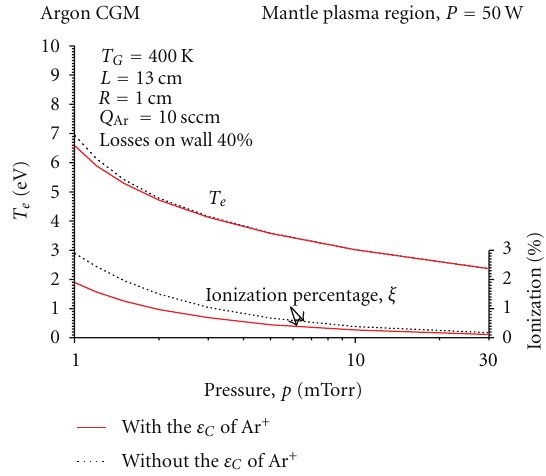
Figure 15: Calculated T e and ionization percentage in the mantle plasma region.